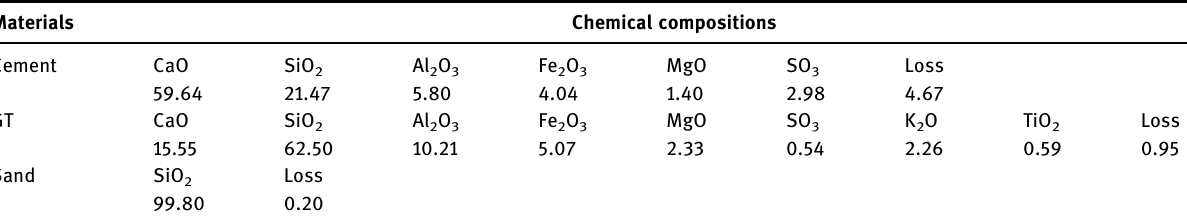
Table 2: Chemical properties of Portland cement, sand, and graphite tailings ( % ) Materials